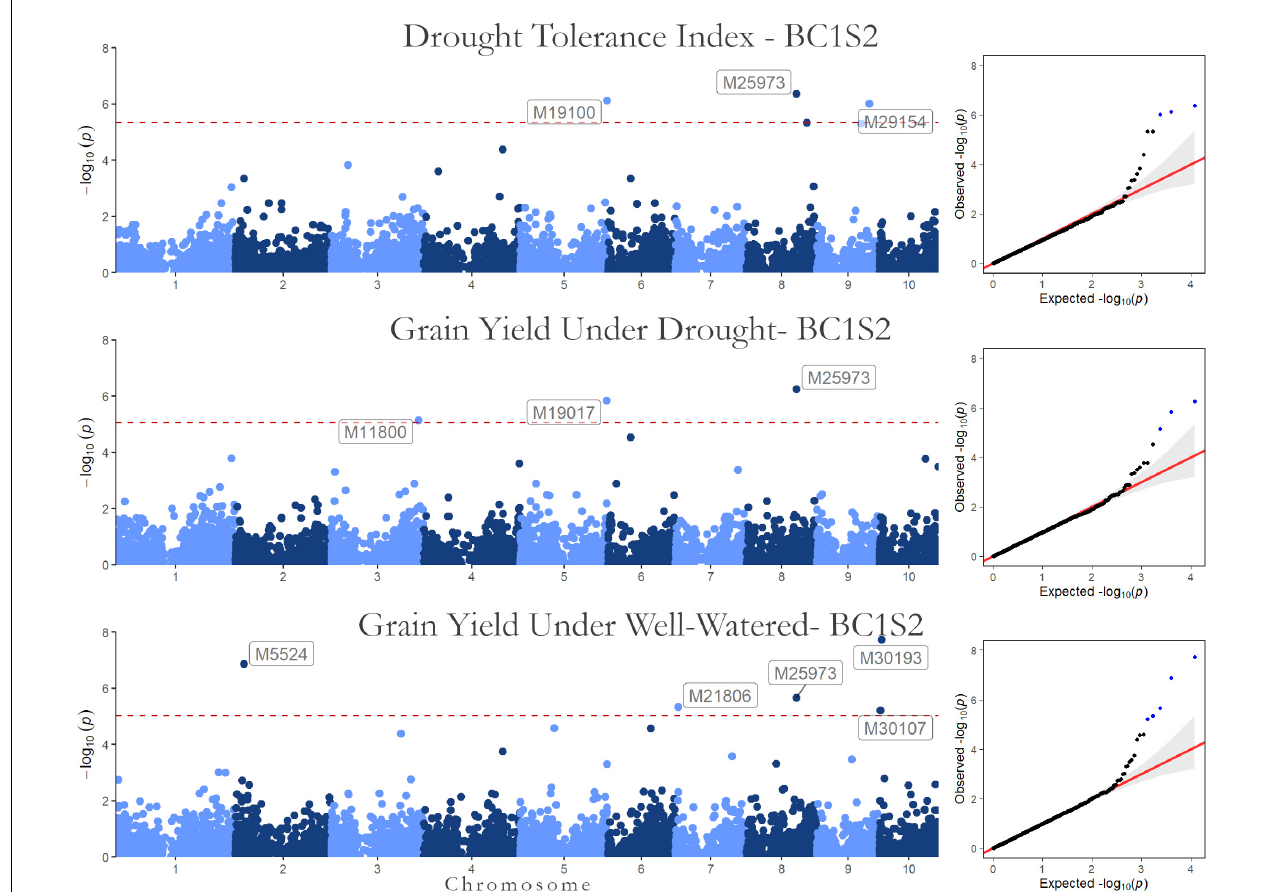
FIGURE 4 | Genome-wide Association results for the second generation (BC1S2-TC2). Manhattan plot and QQ-plot for the drought tolerance index, grain yield in drought, and well-watered conditions.